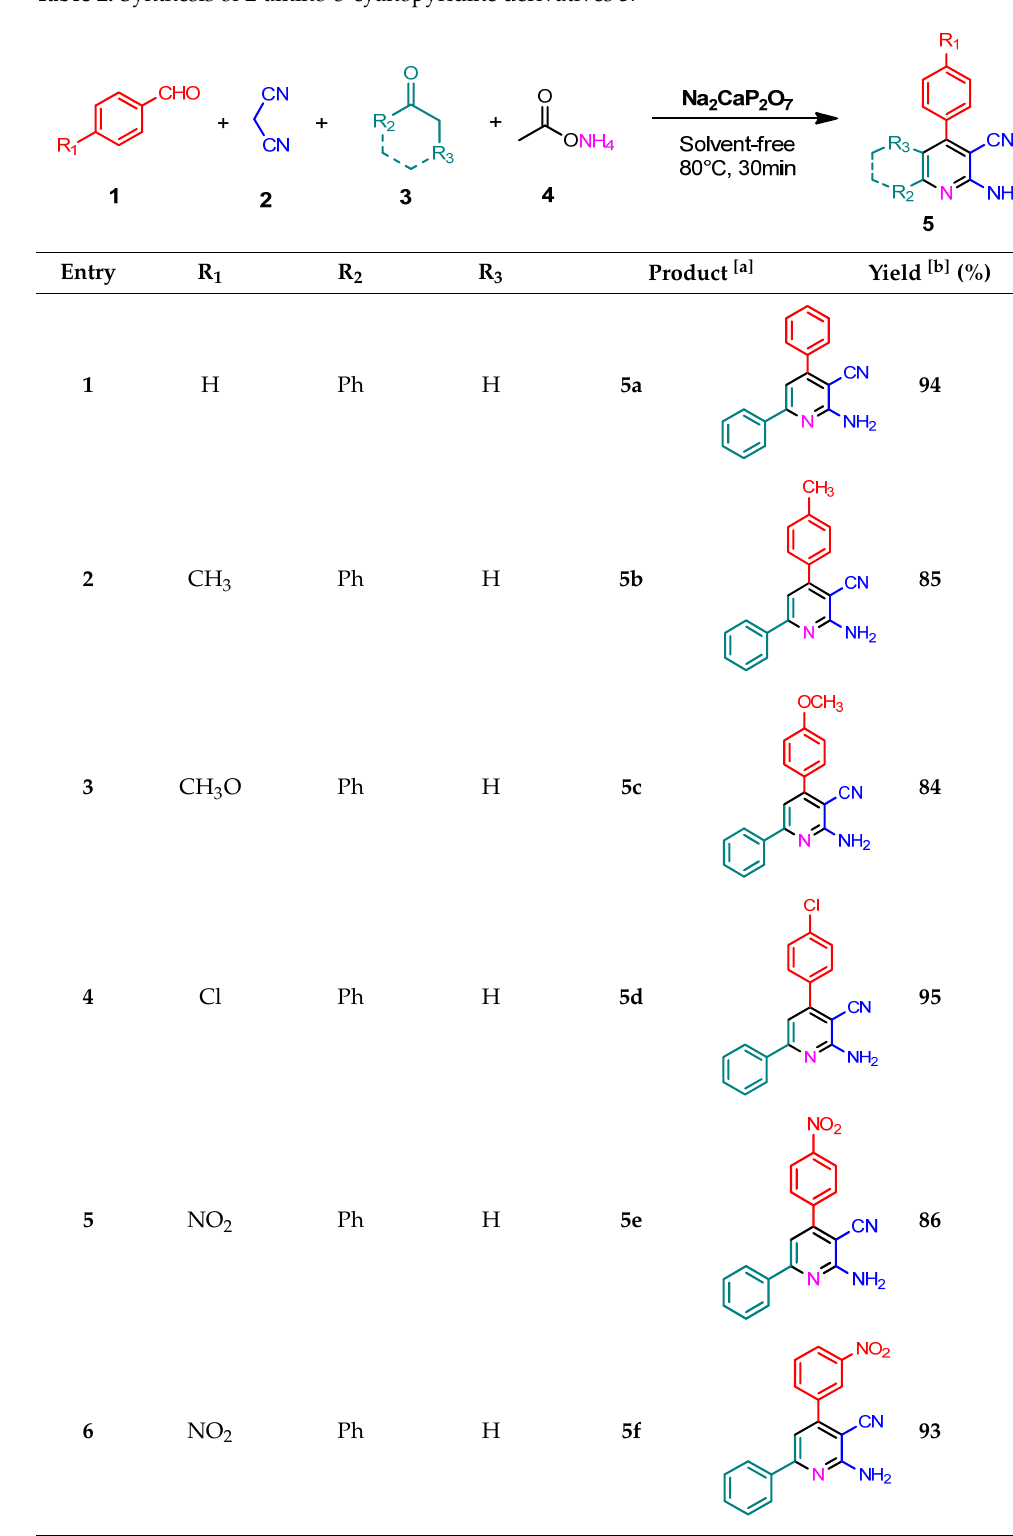
Solvent Figure 7. Influence of the solvent in the catalytic synthesis of 2-amino-3-cyanopyridine 5a . After determining the optimal conditions for the synthesis of 2-amino-3- cyanopyridine 5a, the reactions of different aromatic aldehydes containing substituents in the aromatic ring, such as Me, OMe, Cl, and NO 2 , with malononitrile 2 , acetophenone derivatives, or cyclohexanone 3 and ammonium acetate 4 were carried out under identical